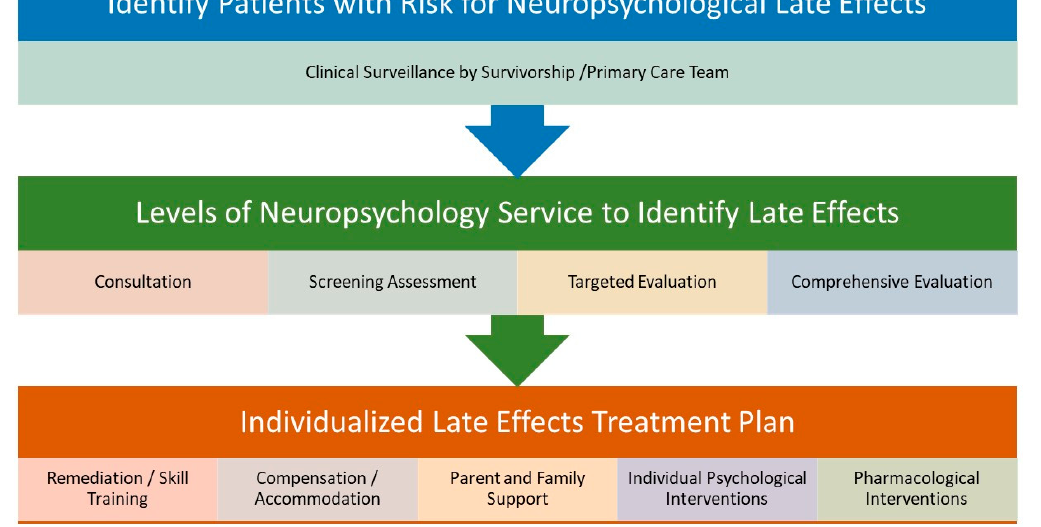
Figure 2. Clinical management of neuropsychological late effects after PBT.